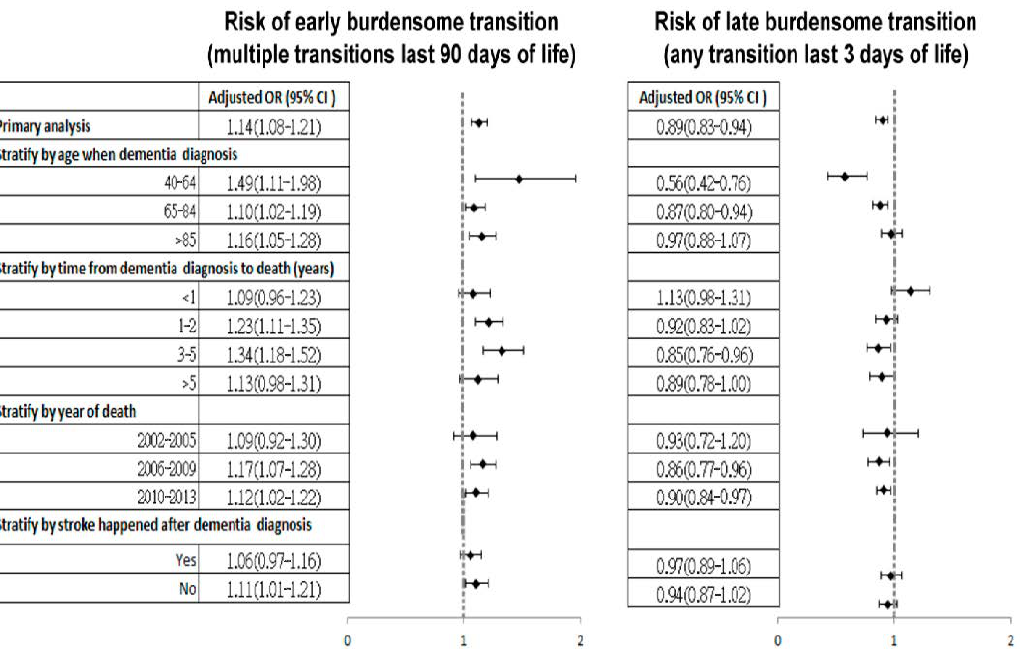
Figure 3. Risk of burdensome end-of-life transition in people with dementia who received home healthcare compared with those who had no home healthcare services (reference group). CI = confidence interval, HHC = home healthcare, ICU = intensive care unit, and OR = odds ratio. * In the regression model, the early burdensome transition represents those with early transition only and those with both early and late transition; the late burdensome transition represents those with late transition only. † All the analyses were adjusted for age, gender, socioeconomic status, age-adjusted Charlson Comorbidity Index, and comorbidities.